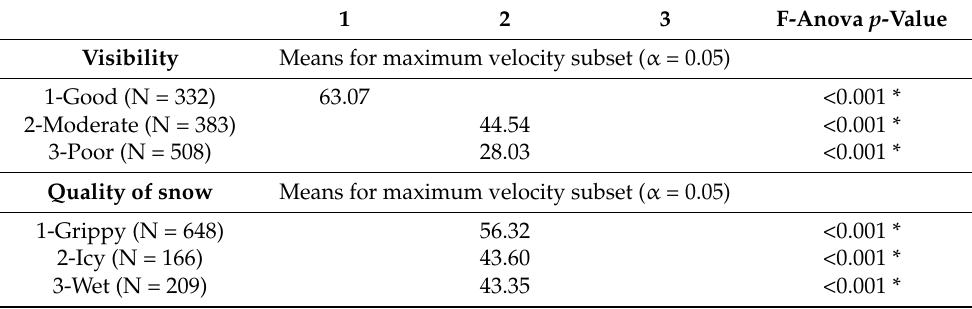
Table 3. ANOVA multiple comparison among categories of environmental